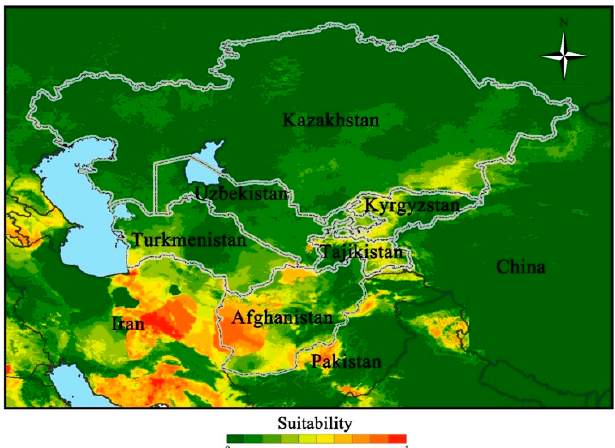
Figure 3. Predicted potential distribution of Spodoptera frugiperda in Central Asia based on the mean model.